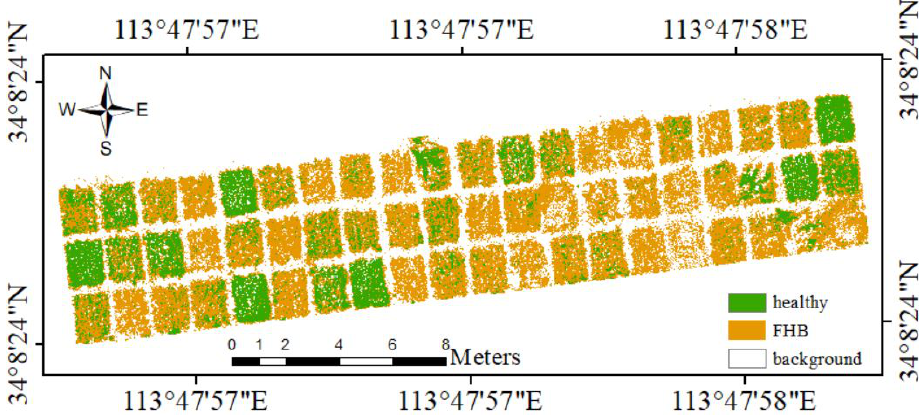
Figure 5. Mapping of the spatial distribution of FHB in wheat.